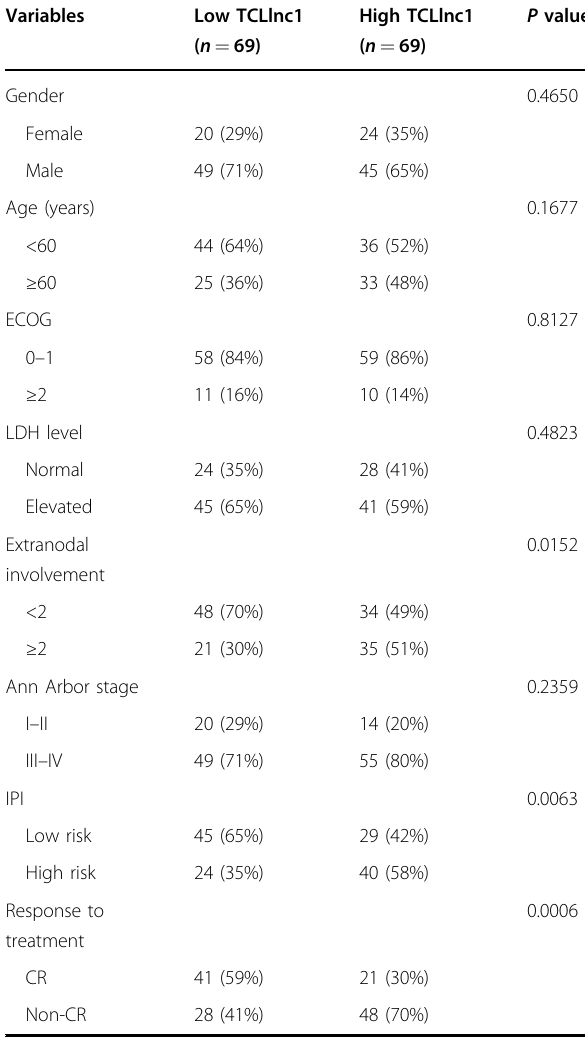
Table 1 Clinicopathological characteristics of PTCL patients according to TCLlnc1 expression in serum ( n = 138) a